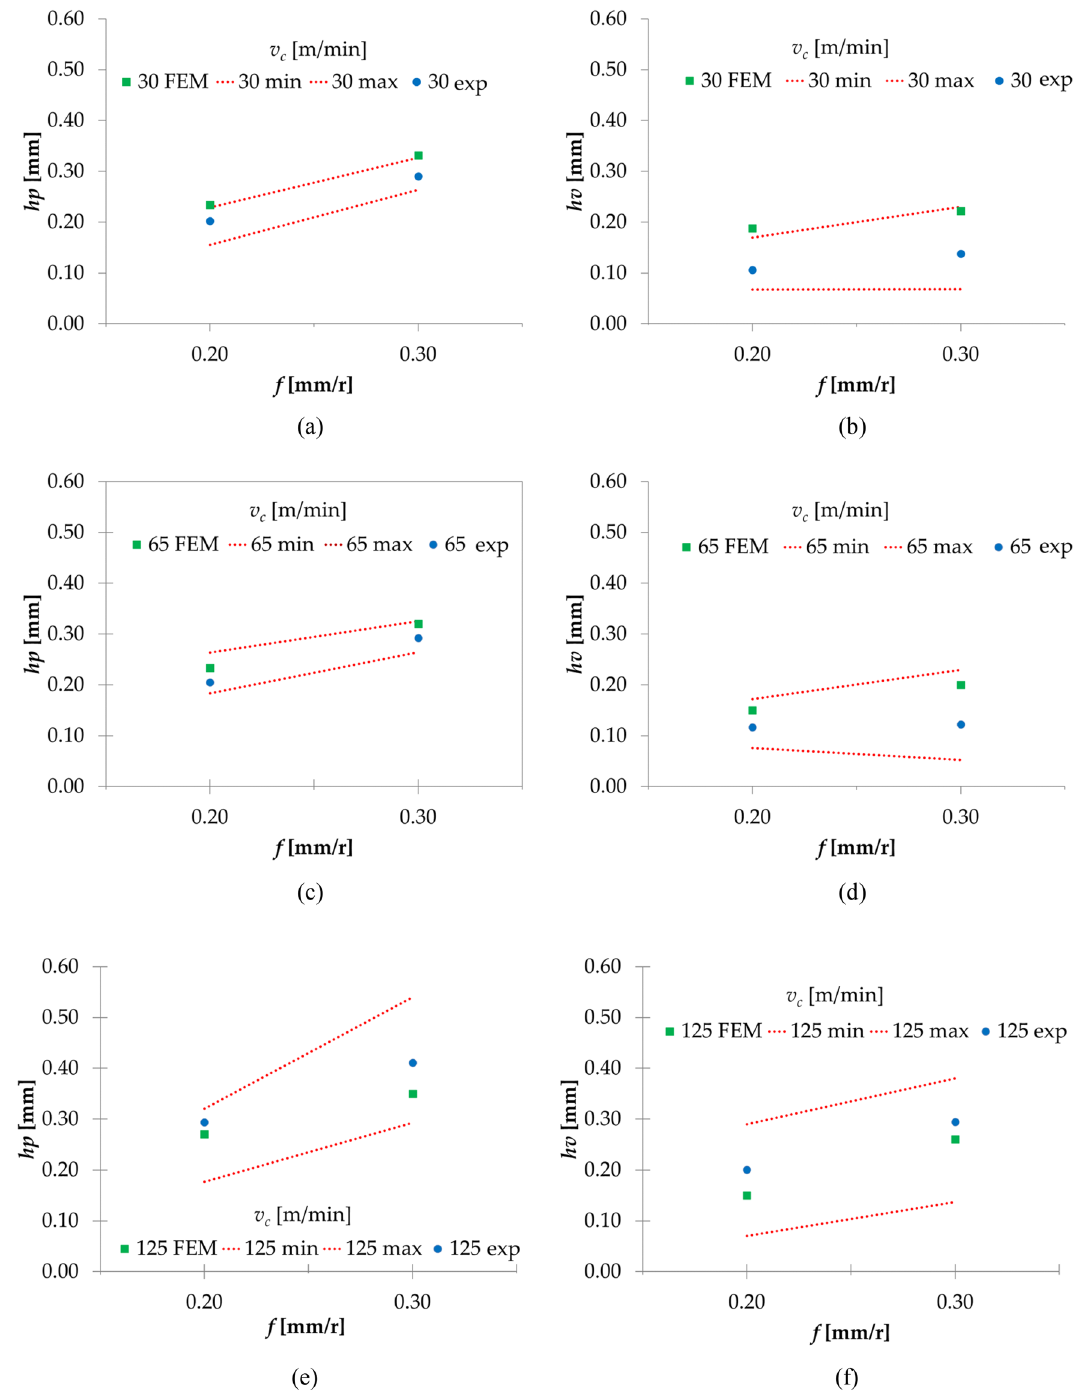
Figure 5. Evolution of h p and h v for the experimental and FEM